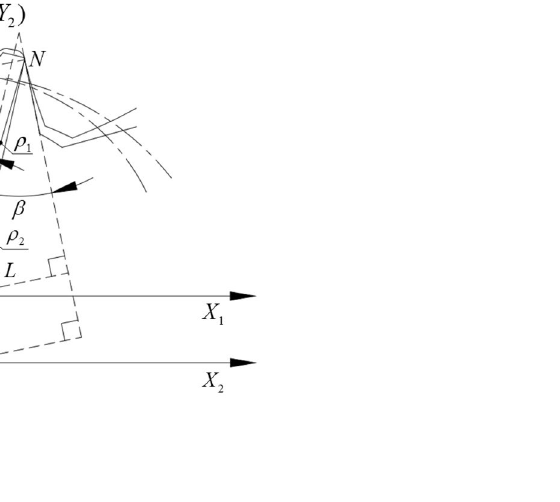
Figure 5. Meshing schematic diagram of the gear